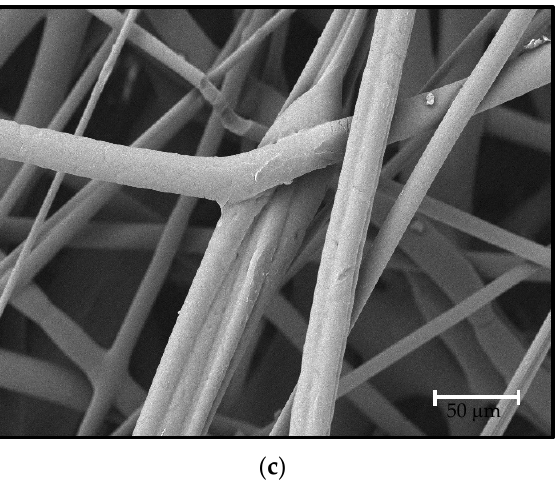
Figure 2. Structural surface morphology SEM images of ( a ) PPDual ‐ S; ( b ) PPDual ‐ M; ( c ) PPDual ‐ L. Increasing polymer throughput tends to decrease the thickness and increase solidity.